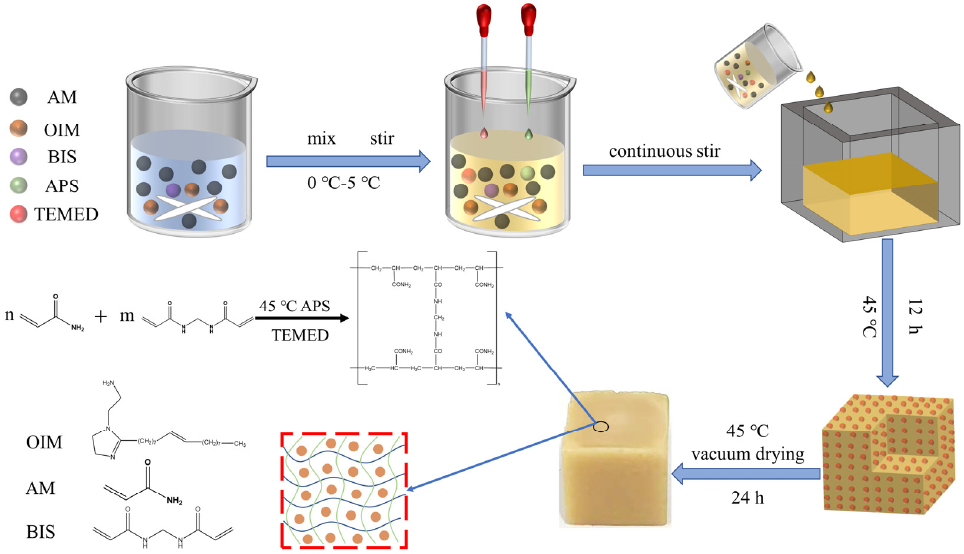
Figure 13. Schematic diagram of the synthesis of OIM@PAM solid corrosion inhibitors.